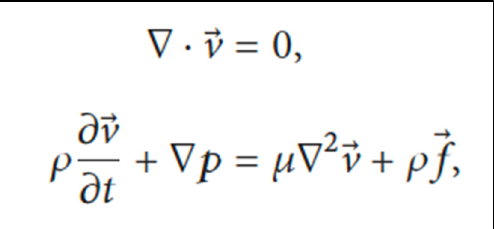
Figure 3. Navier–Stokes equations to investigate the movement of urine within the ureter. Legend: v = spatial velocity vector; 𝜌 = fluid density; 𝑝 = static pressure; 𝜇 = dynamic viscosity; 𝑓 = body v = spatial velocity vector; ρ = fluid density; p = static pressure; µ = dynamic viscosity; f = body force vector. force